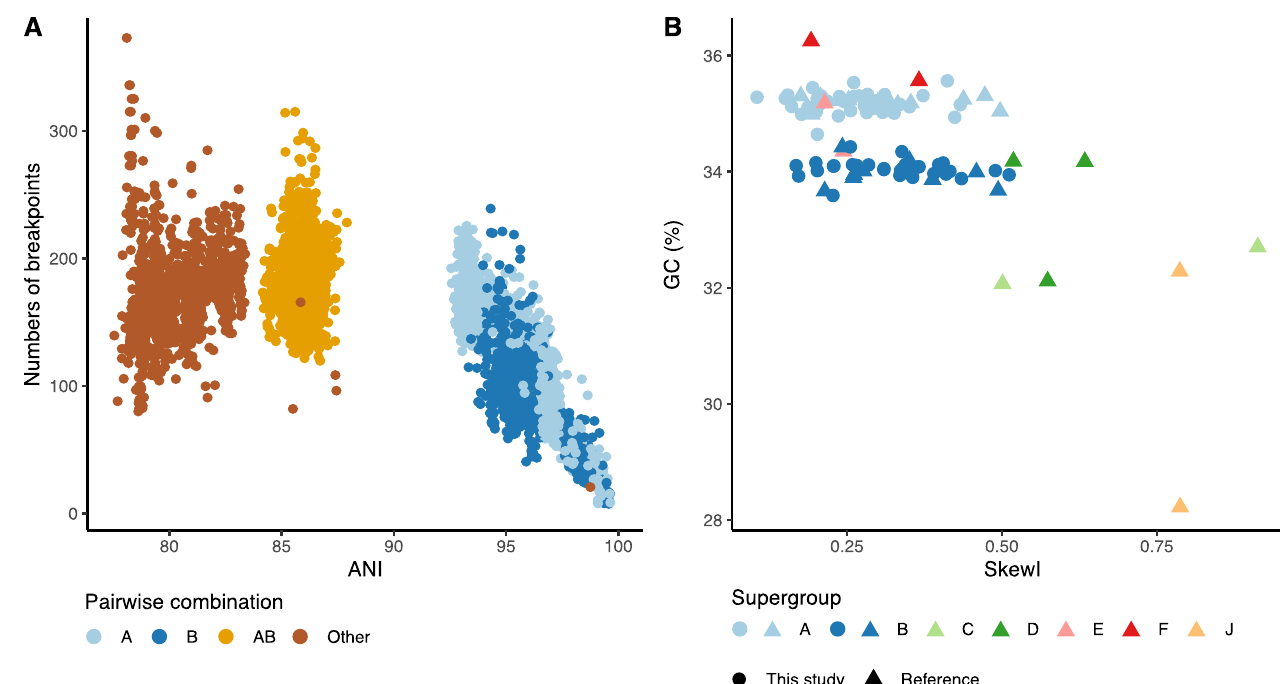
Fig 3. Comparative genomics of Wolbachia . (A) Whole-genome average nucleotide identity (ANI) plotted against the number of breakpoints in comparisons within A supergroup genomes, within B, between A and B and between other supergroup Wolbachia . The data underlying this Figure can be found in S1 Data. (B) Index of skewness compared to GC content for all circularised Wolbachia genomes. The data underlying this Figure can be found in S1